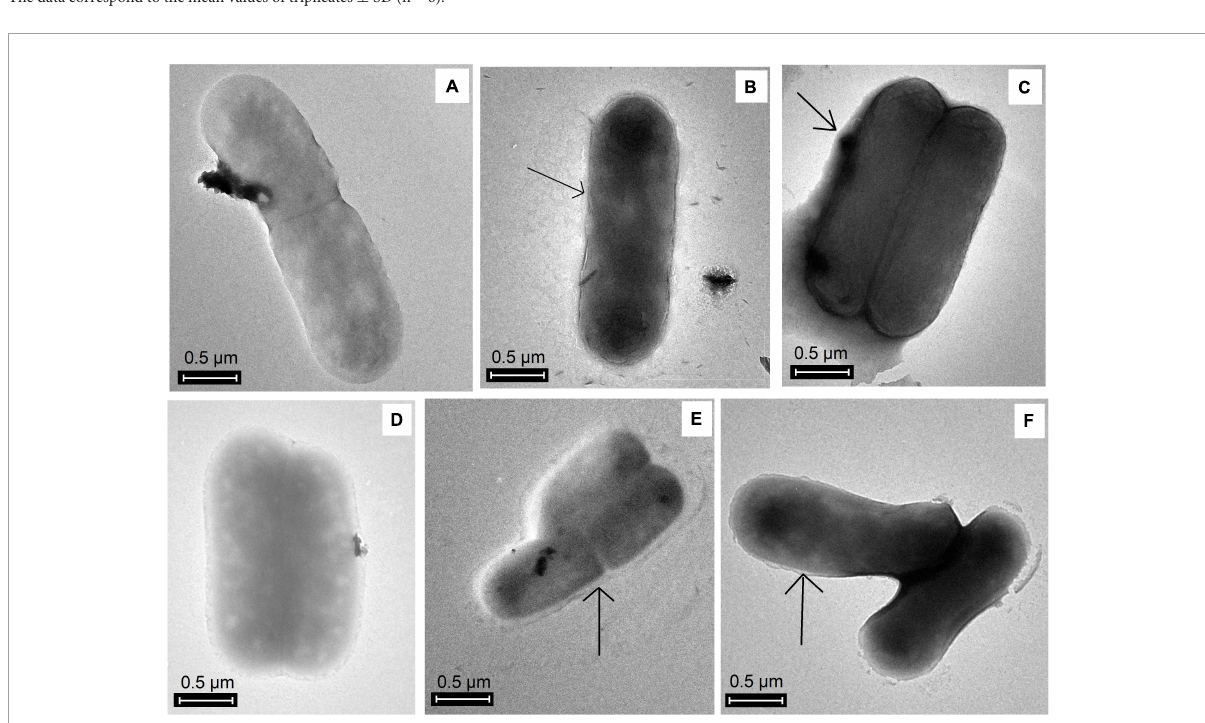
FIGURE2 TEM images of EPS production by A. ferrooxidans in planktonic phase induced with different concentrations of iron and galactose. (A) Af9, (B) Af9015, (C) Af9025, (D) Af18, (E) Af18015, (F) Af18025. Black arrows show the presence of